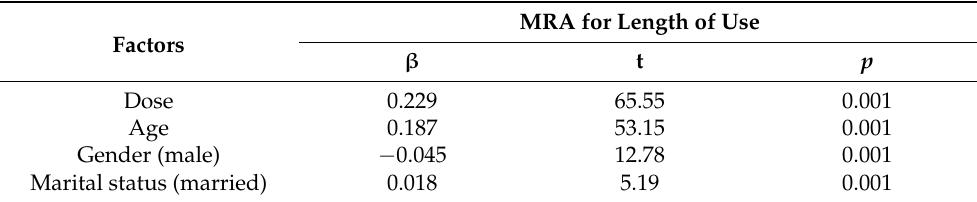
Table 5. The influence of different parameters on length of use of benzodiazepines. Factors